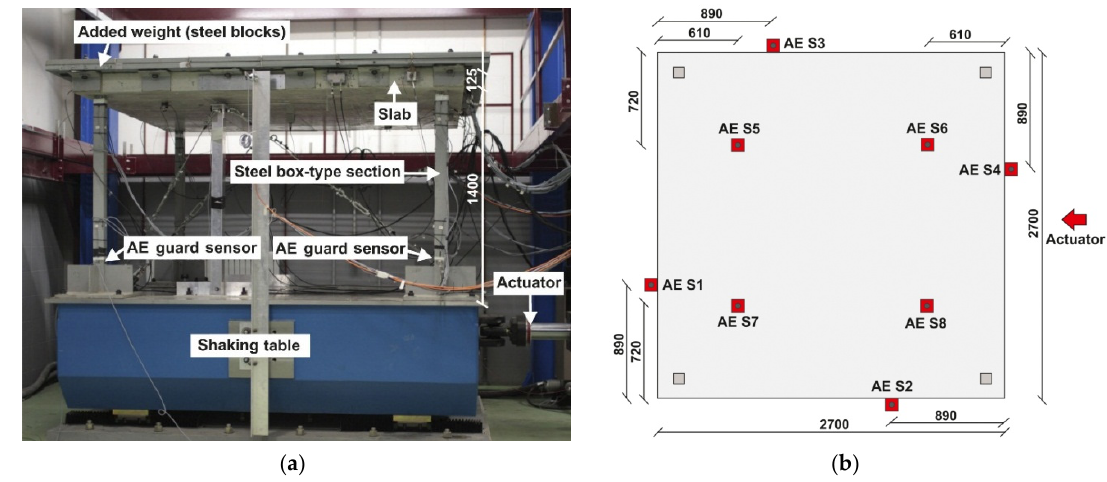
Figure 15 . RC slab with AE sensors (S1 to S8) on the shaking table. ( a ) Elevation. ( b ) Plan (bottom view). Distances in mm.